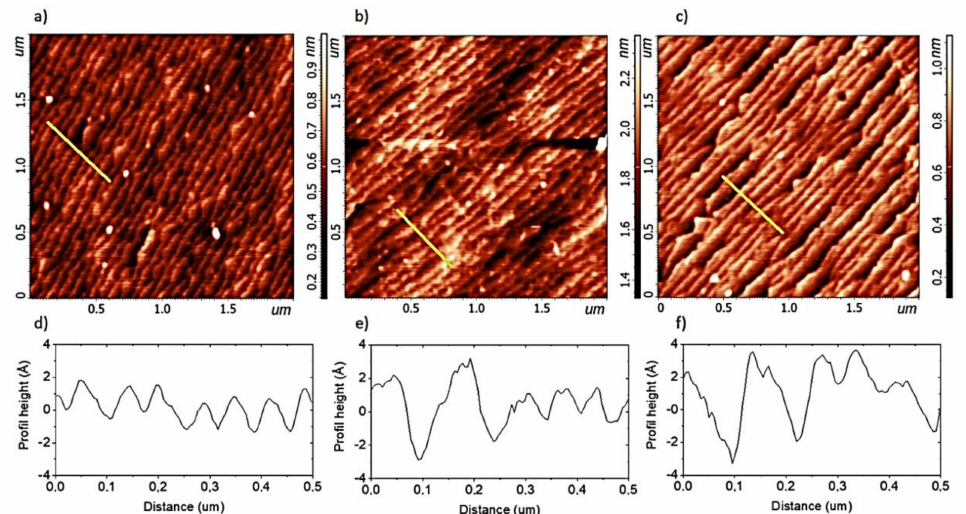
Figure 1. The AFM measurements of the surfaces of the STO samples prepared with di ff erent methods ( a ) acid, ( b ) bu ff er, ( c ) DIW, with the corresponding height profiles measured perpendicular to the terraces ( d – f ) marked as the yellow line on the AFM